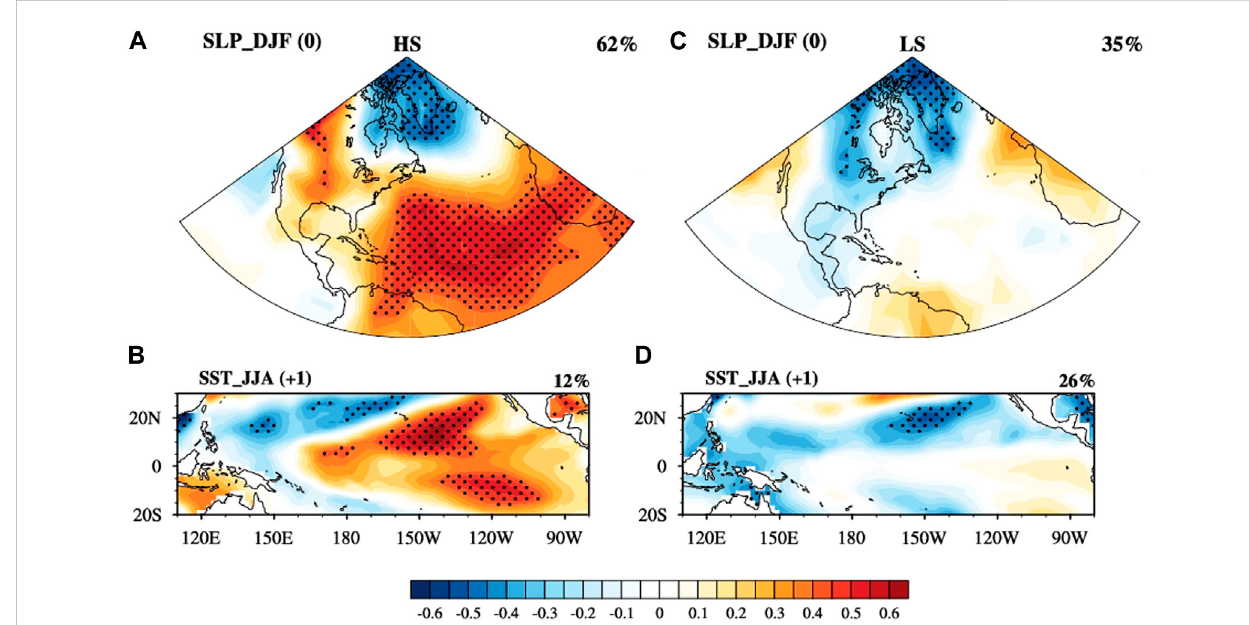
FIGURE 4 (A – D) Are the same as Figures 2C,D, but for the observed DJF-mean SLP and 1-year lagged JJA-mean SST anomalies in subsets of the high solar activity (HS, left column) and the low solar activity (LS, right